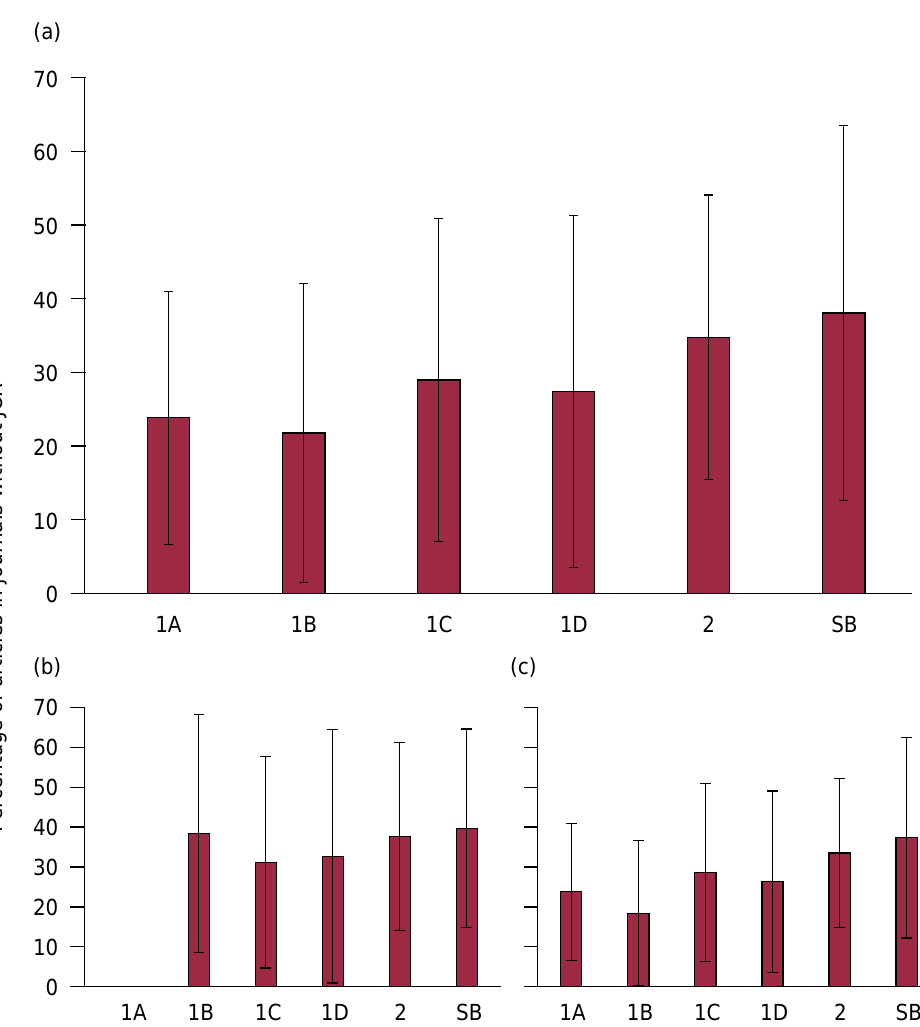
Figure 8. Percentage of articles published in journals without JCR in relation to the total of articles published in the last five years (January 2013 to October 2018), by PQ fellowship class and non-fellows (SB), for all researchers regardless of gender (a) and by gender women (b) and men (c), in CNPq Call